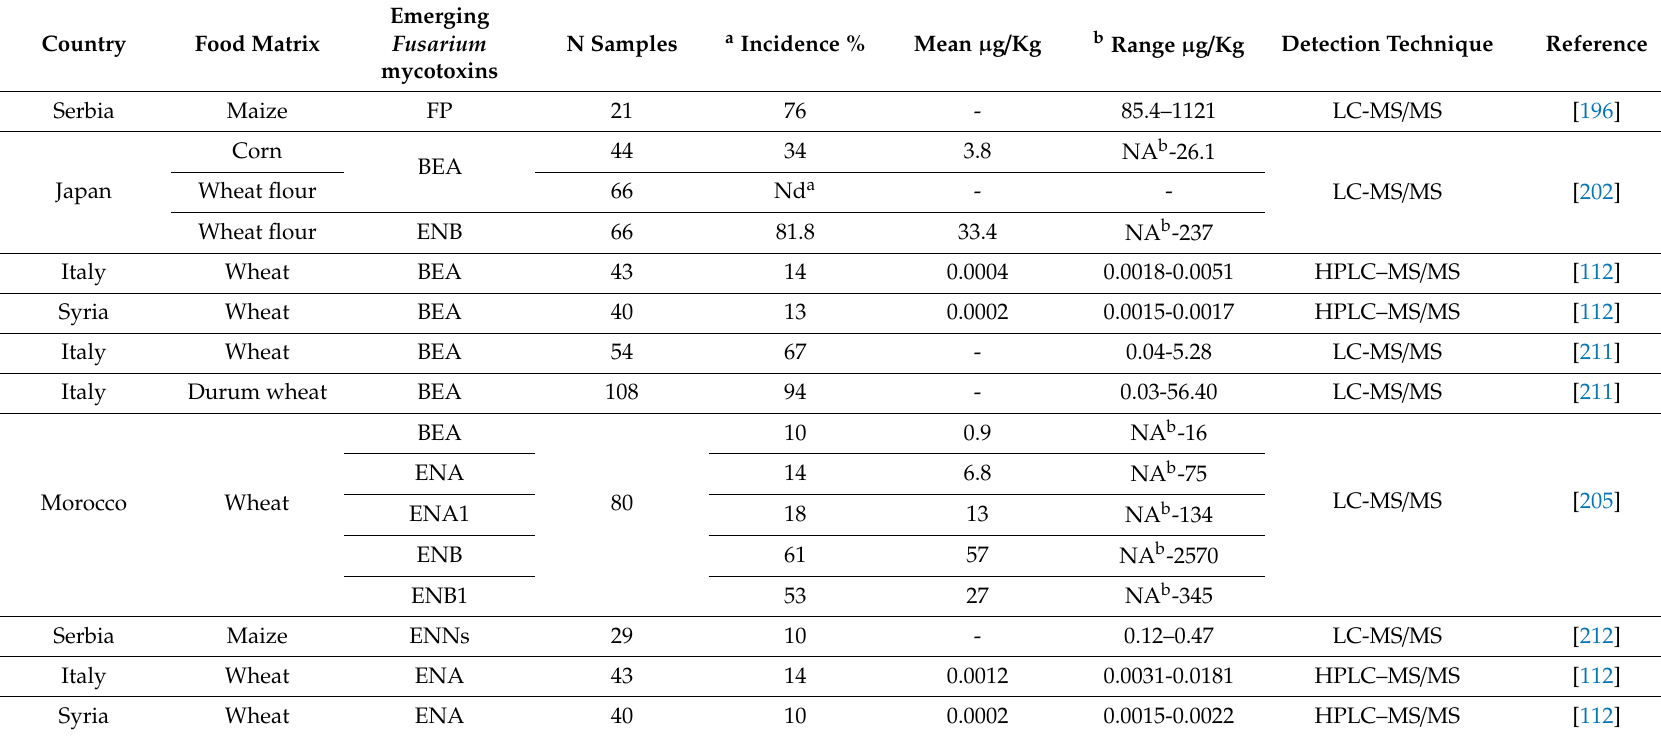
Table 9. Representative studies on the occurrence of emerging Fusarium mycotoxins distribution ( µ g / Kg) in food samples around the world during 2014–2019.